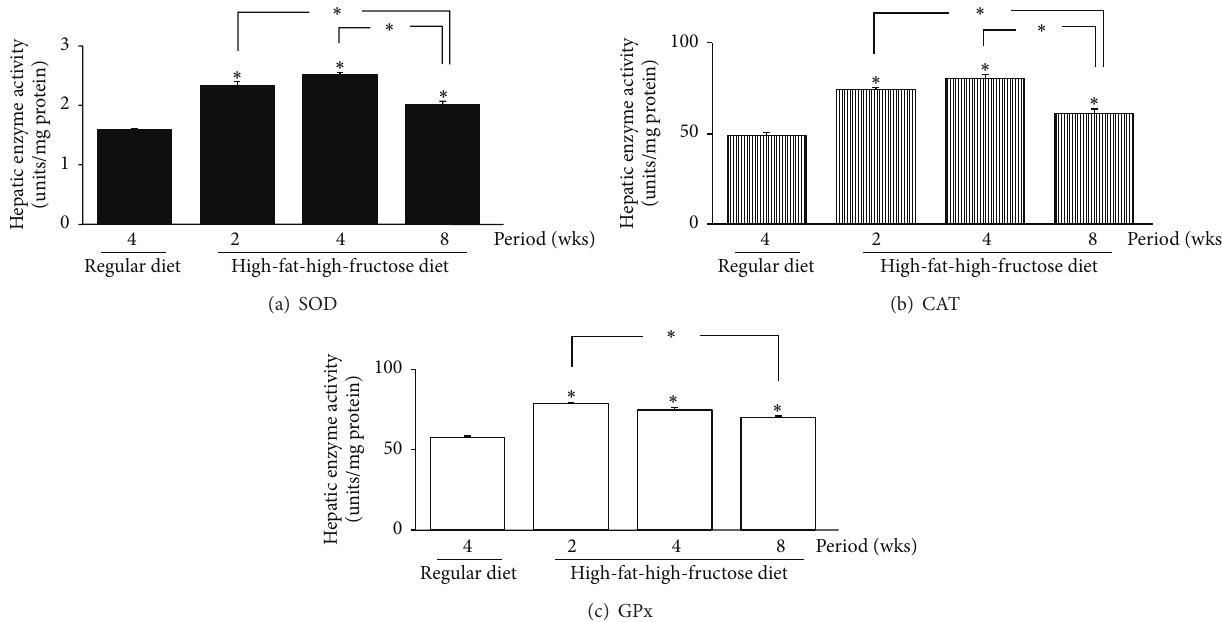
Figure 3: Effects of a high-fat, high-fructose diet on hepatic SOD, CAT, and GPx enzymatic activity. Mice were fed a commercial standard diet for 4 weeks, and a high-fat, high-fructose diet (HFFD) was administered intragastrically for 2, 4, or 8 weeks. The mice were sacrificed 24 h after the last treatment, and their livers were immediately excised to determine the activities of the SOD, CAT, and GPx enzymes. The data are presented as the mean ± SD ( 𝑛 = 5 ). Significant differences were determined using a one-way analysis of variance (ANOVA) followed by Tukey’s post hoc test. ∗ 𝑝 < 0.05 versus the regular diet